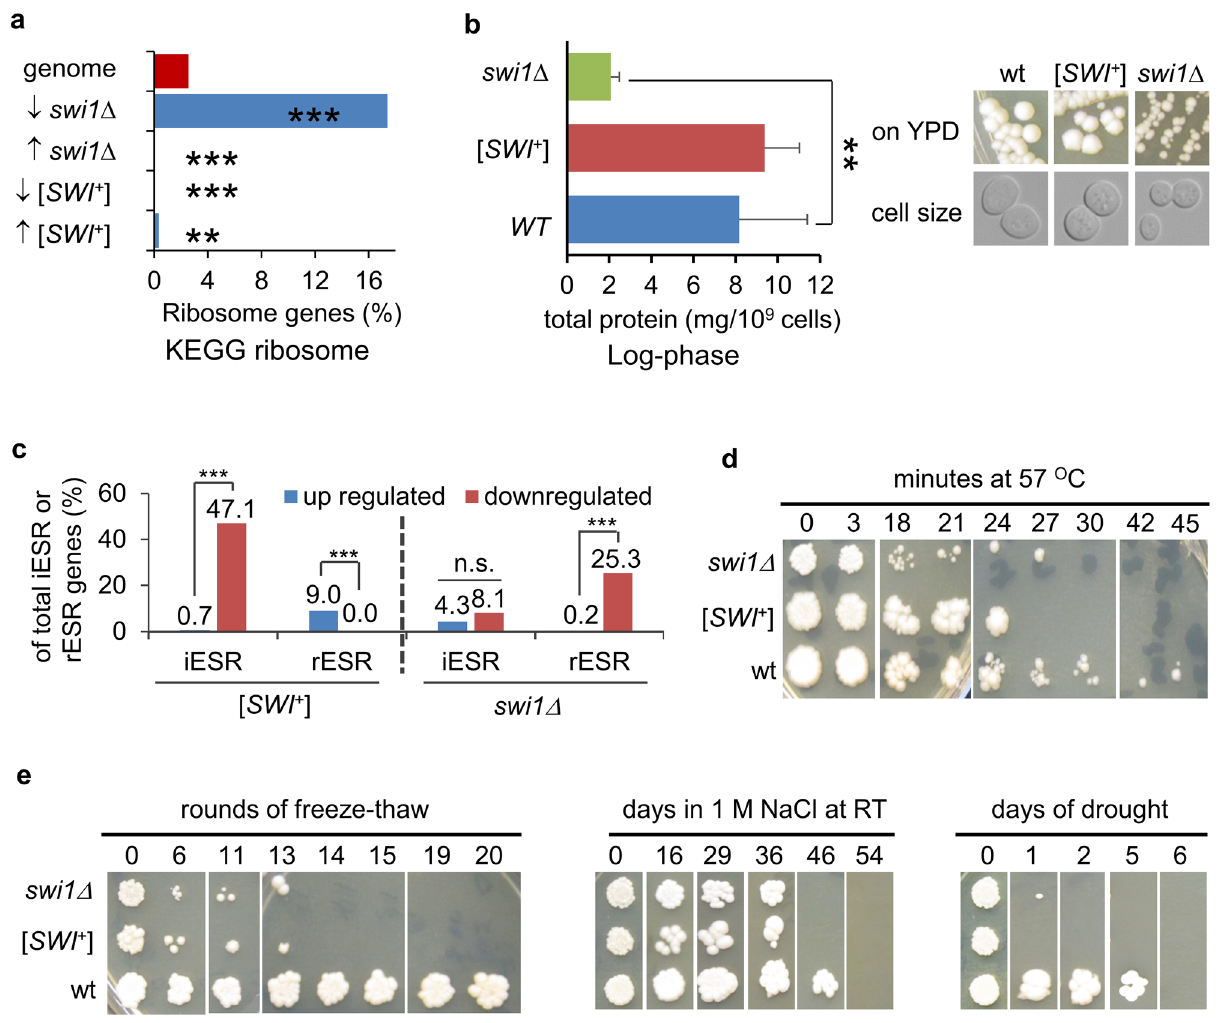
Figure 6. Analyses of protein synthesis and Environmental Stress Response (ESR) of swi1∆ and [ SWI + ] cells. ( a ) KEGG ribosome gene enrichment analysis was performed as described in the Methods. ↑ and ↓ indicate upregulation and downregulation by swi1∆ or [ SWI + ], respectively. ( b ) Left: shown are the steady state protein levels of the indicated strains. The total protein concentration normalized to cell number was determined for log-phase cells by a protein assay as described in the method. Right: images showing cell size and growth phenotype of the three strains used in this study. ( c ) Shown are fractions of environmental stress response (ESR) genes including iESR and rESR genes that are either activated or repressed in [ SWI + ] and swi1∆ cells. The significance was analyzed by Fisher’s exact test for panels of ( a , c ) and Student T-test for panel ( b ). *p-value < 0.05; **p-value < 0.001; ***p-value < 0.001. ( d , e ) Shown are cell viability assays of the three tested strains upon the indicated treatments as described in the